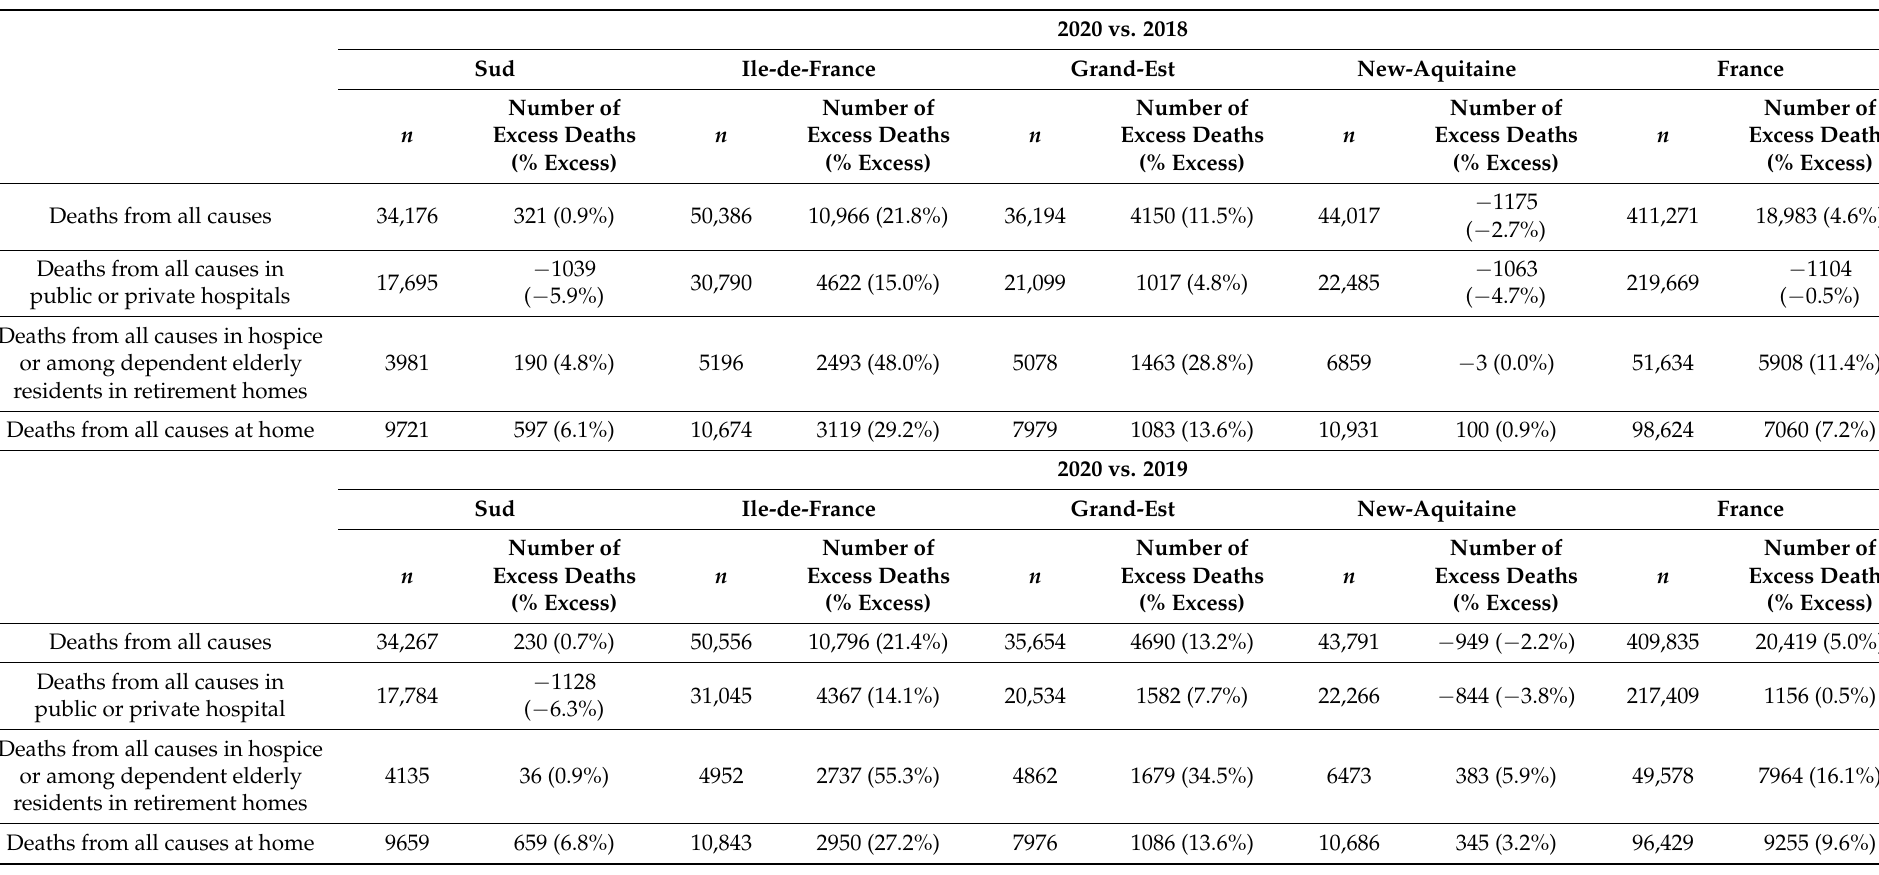
Table 2. Excess mortality in 2020 compared to 2018/2019 from January to August in France, including 4 regions. The data were collected from the INSEE